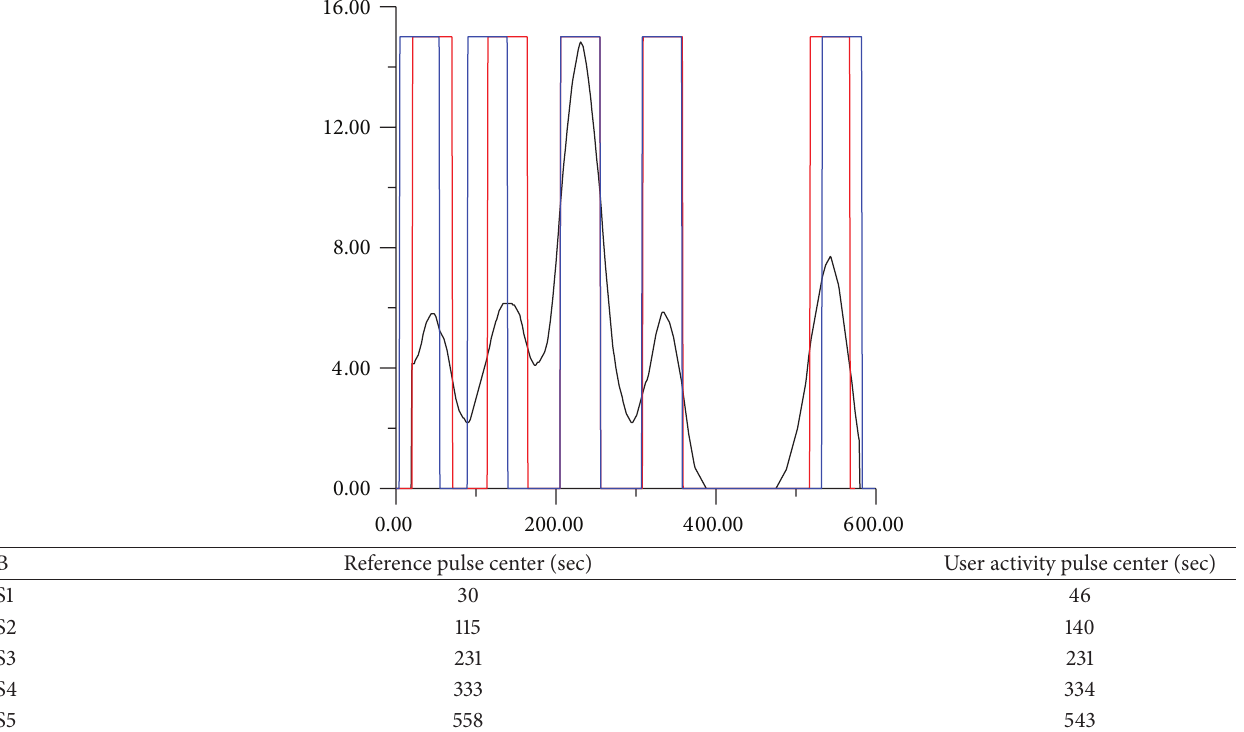
Table 3: Video B is a documentary video (http://www.youtube.com/watch?v=tSV2kAfkp5A). The pulse width 𝐷 is 50 seconds and the smoothing window 𝑇 is 40 seconds. The pulse modeling is reported with respect to the center of each